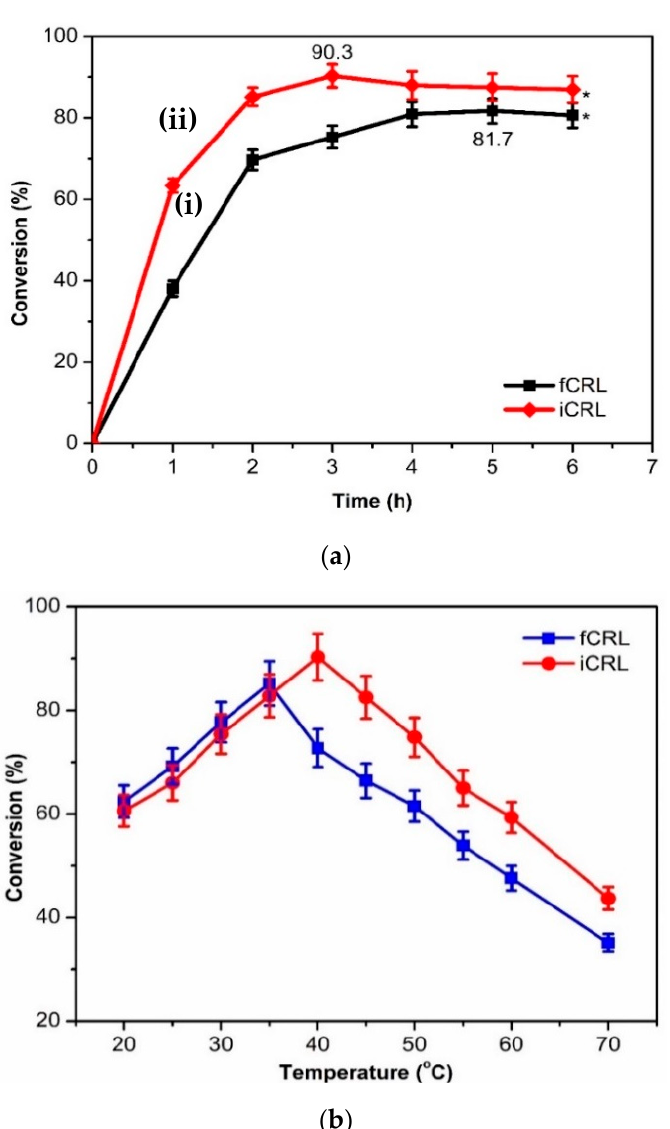
Figure 4. ( a ) The effect of reaction time on the synthesis of EV catalyzed by free CRL and CRL/SiO 2 /Fe 3 O 4 /GO biocatalysts (3mg/mL, 40 ◦ C, acid/butanol molar ratio 1:2, 200rpm). * Inde- pendent t -test revealed a significant difference between the effects of reaction time to affect the percent- age conversion of EV ( p < 0.05), and ( b ) the thermal stability of free CRL and CRL/SiO 2 /Fe 3 O 4 /GO biocatalysts in the esterification synthesis of EV 3mg/mL, acid/ethanol molar ratio 1:2, 200rpm, 3